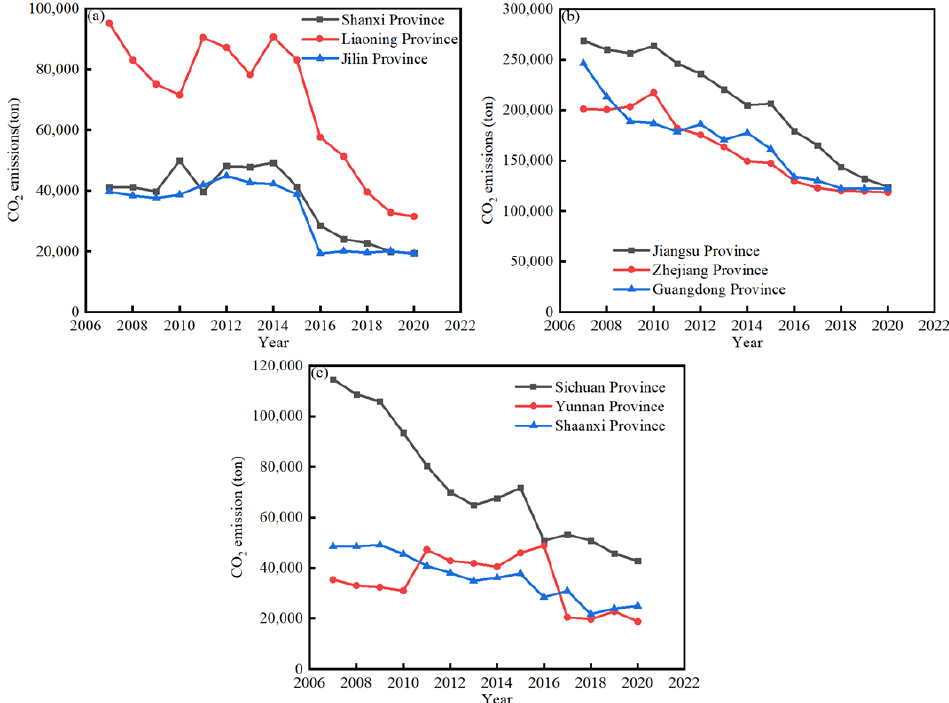
Figure 1. ( a ) Shanxi, Liaoning, and Jilin Provinces; ( b ) Jiangsu, Zhejiang, and Guangdong Provinces; ( c ) Sichuan, Yunnan, and Shaanxi Provinces. Change in CO 2 emissions over time (2006–2020) (Data: IBRD. IDA).